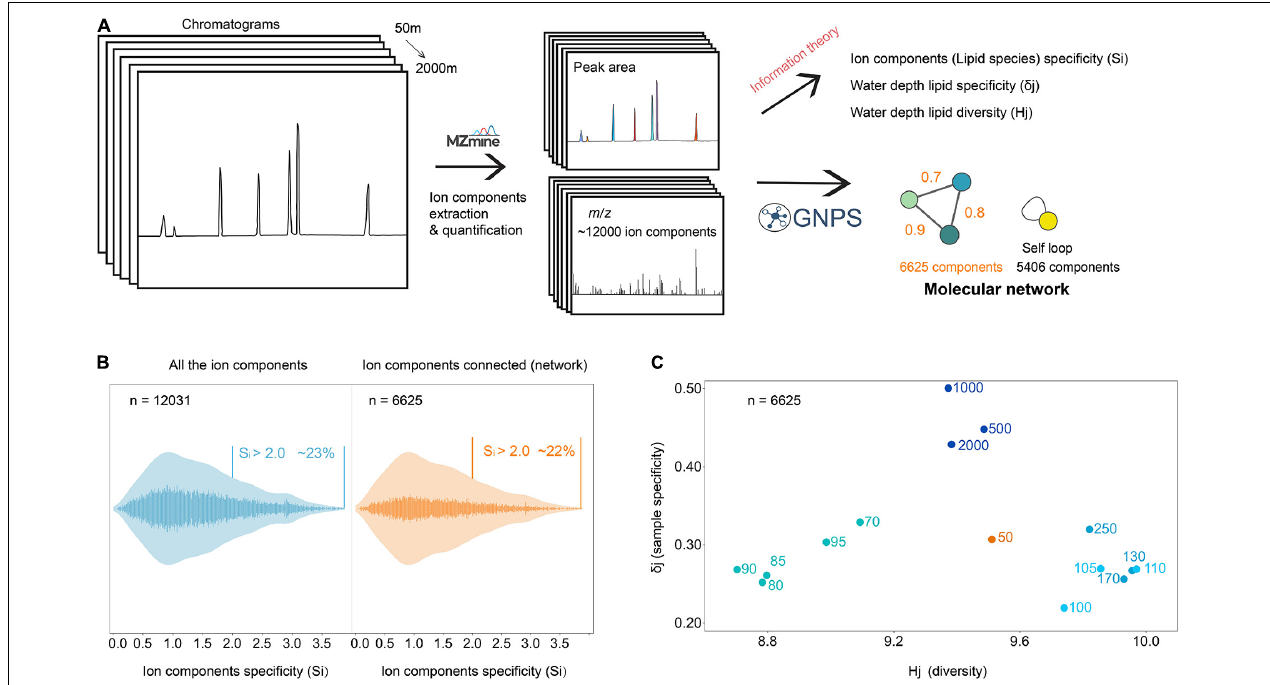
FIGURE 1 | Testing the specificity and diversity of lipid species in the water column of the Black Sea using information theory and molecular network. (A) Schematic overview of the lipidomic data process and analysis workflow . (B) Specificity of the ion components among all the water column samples, left showed all the ion components while right showed the ion components connected through molecular network. Y axis represents the ion component counts, the different tones represent the trends of ion component specificity. The percentage shown here stands for the proportion of ion components that had high specificity (Si > 2), i.e., ca. 23% of all the ion components had high specificity Si > 2. (C) Scatter plot of Hj (diversity) vs. δ j